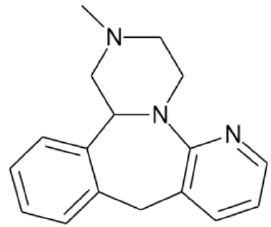
Figure 1. Chemical structure of mirtazapine.